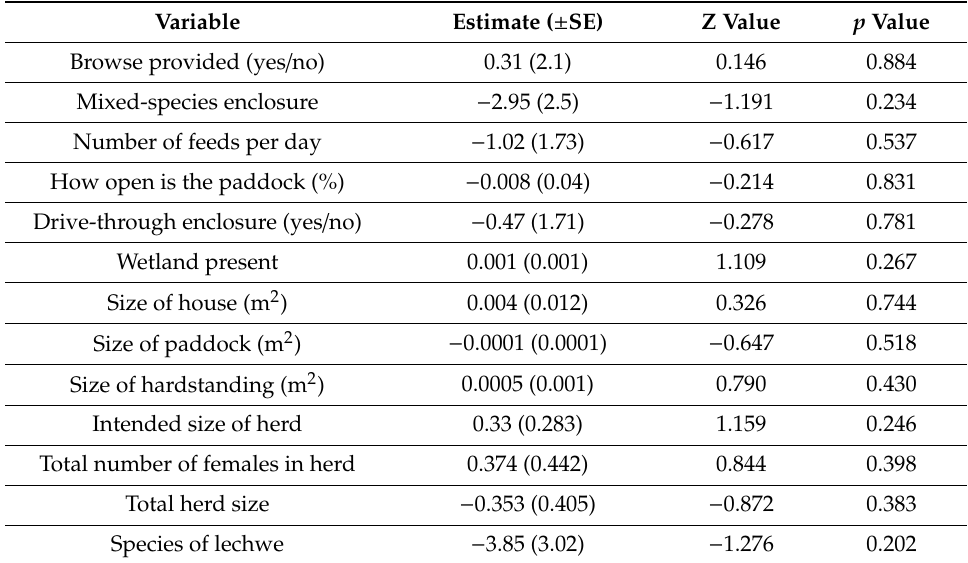
Table 6. BinomialGLMoutputforpredictorsofstereotypicbehaviourperformedfromallreturnedsurveys.